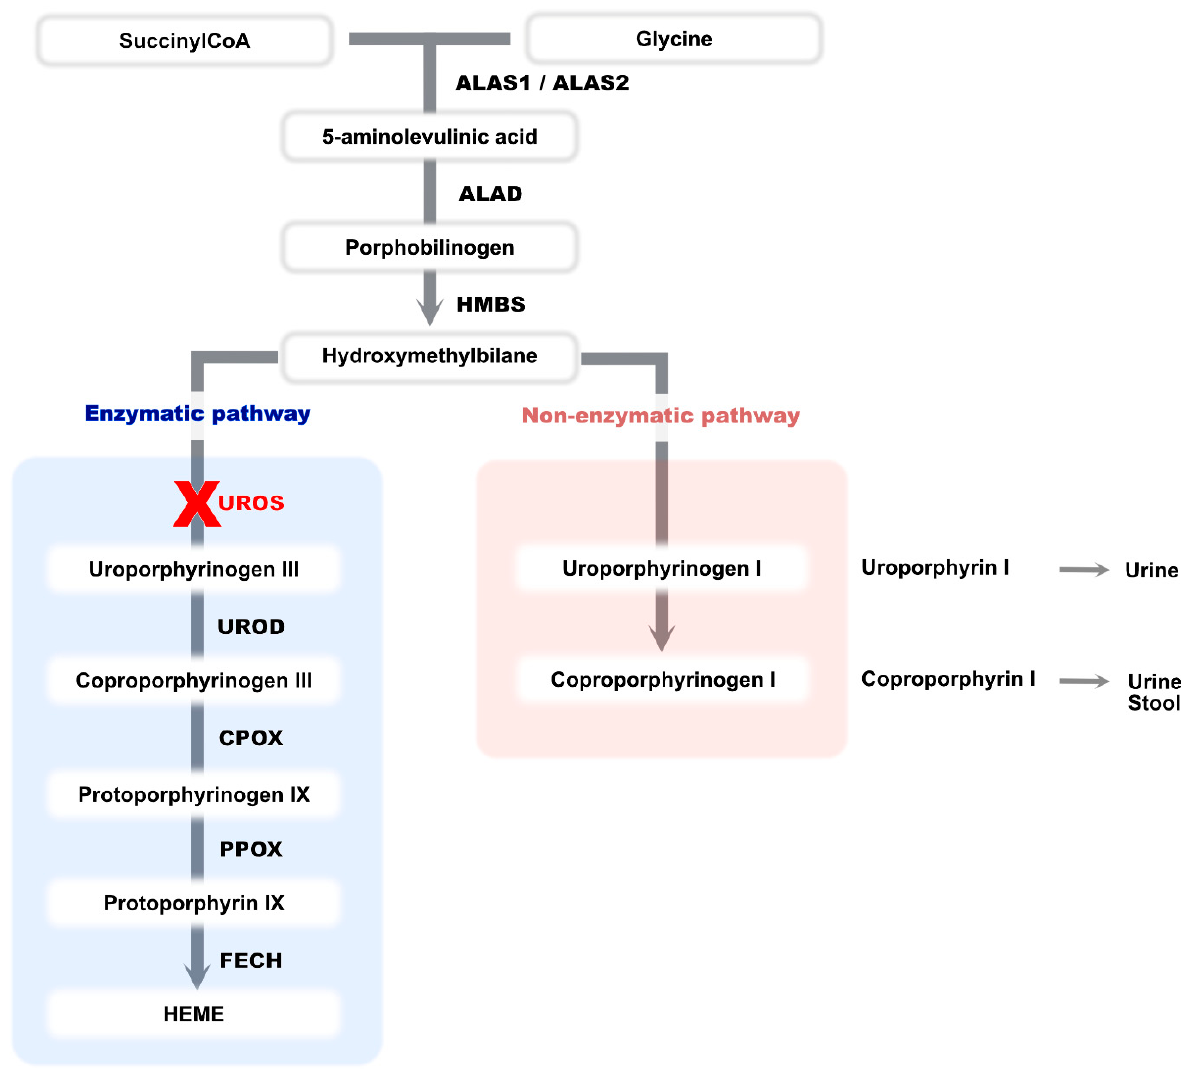
Figure 1. The human biosynthetic pathway of heme. ALAS: Aminolevulinic acid synthase, ALAD: Aminolevulinic acid dehydratase, HMBS: Hydroxymethylbilane synthase, UROS: Uroporphyrinogen III synthase, UROD: Uroporphyrinogen decarboxylase, CPOX: Coproporphyrinogen oxidase, PPOX: Protoporphyrinogen oxidase, FECH: Ferrochelatase.